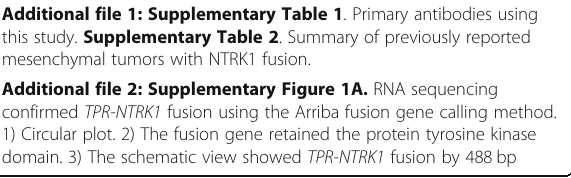
Additional file 1: Supplementary Table 1 . Primary antibodies using this study. Supplementary Table 2 . Summary of previously reported mesenchymal tumors with NTRK1